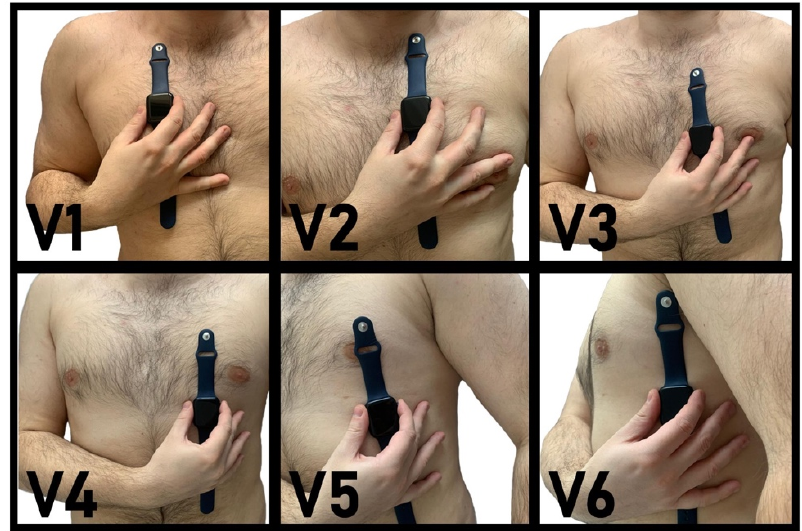
Figure 1. The positioning of the Apple Watch Series 4 for obtaining precordial leads. In the Apple Watch, the negative electrode is placed in the digital crown and the positive electrode is on the back crystal of the watch. The patient is in supine position.